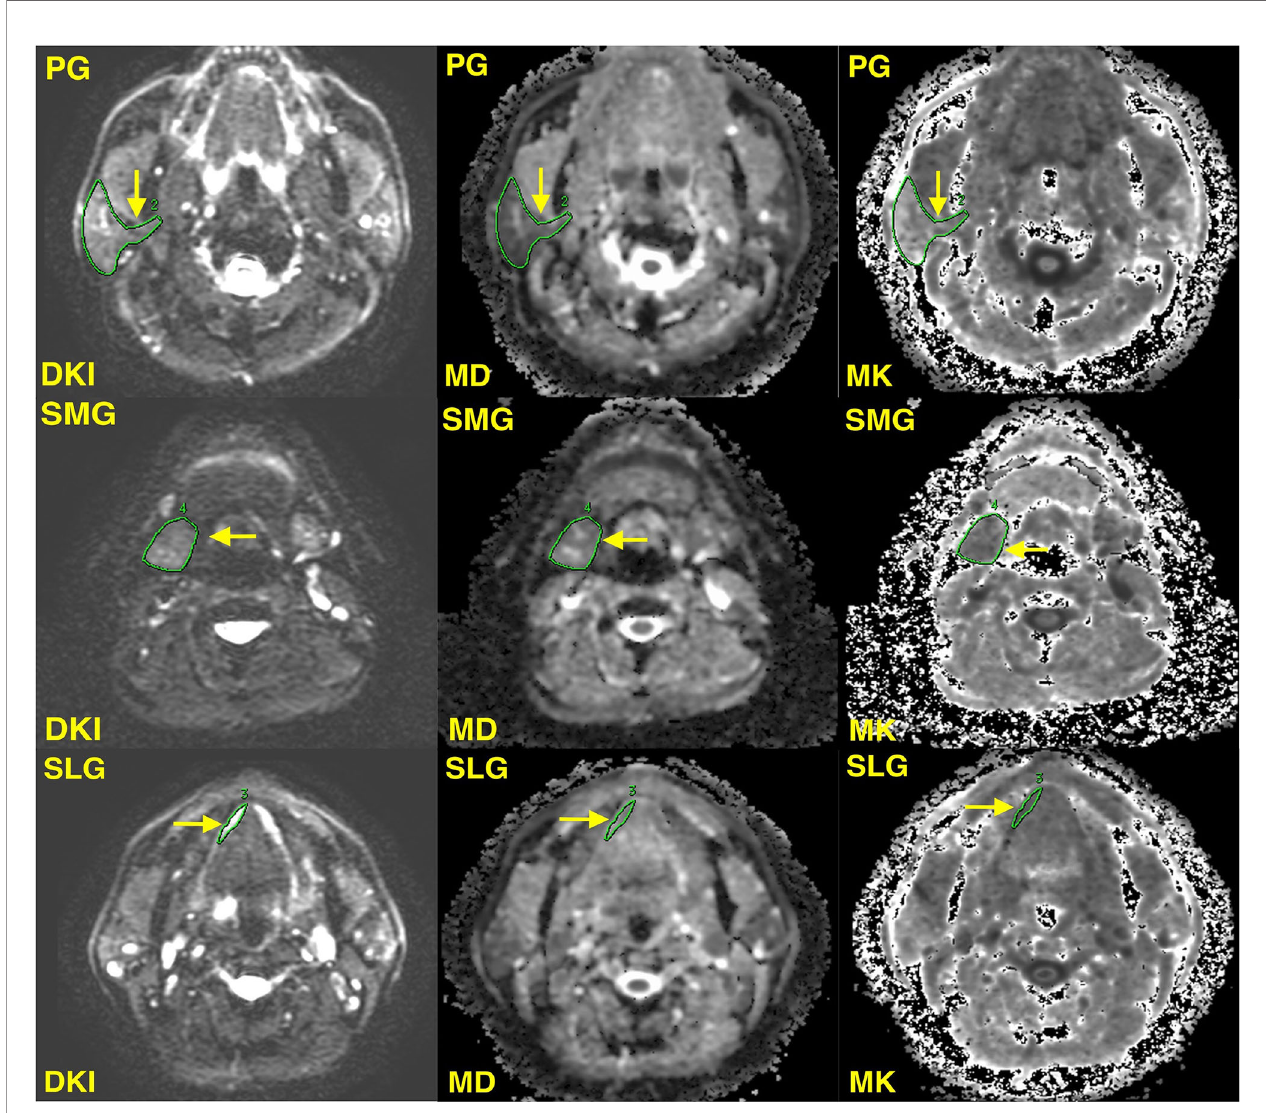
FIGURE 1 | Illustrations of the region of interest of the right parotid gland (PG), sublingual gland (SLG), and submandibular gland (SMG) (yellow solid arrow). DKI, diffusion kurtosis imaging; MD, mean diffusion; MK, mean